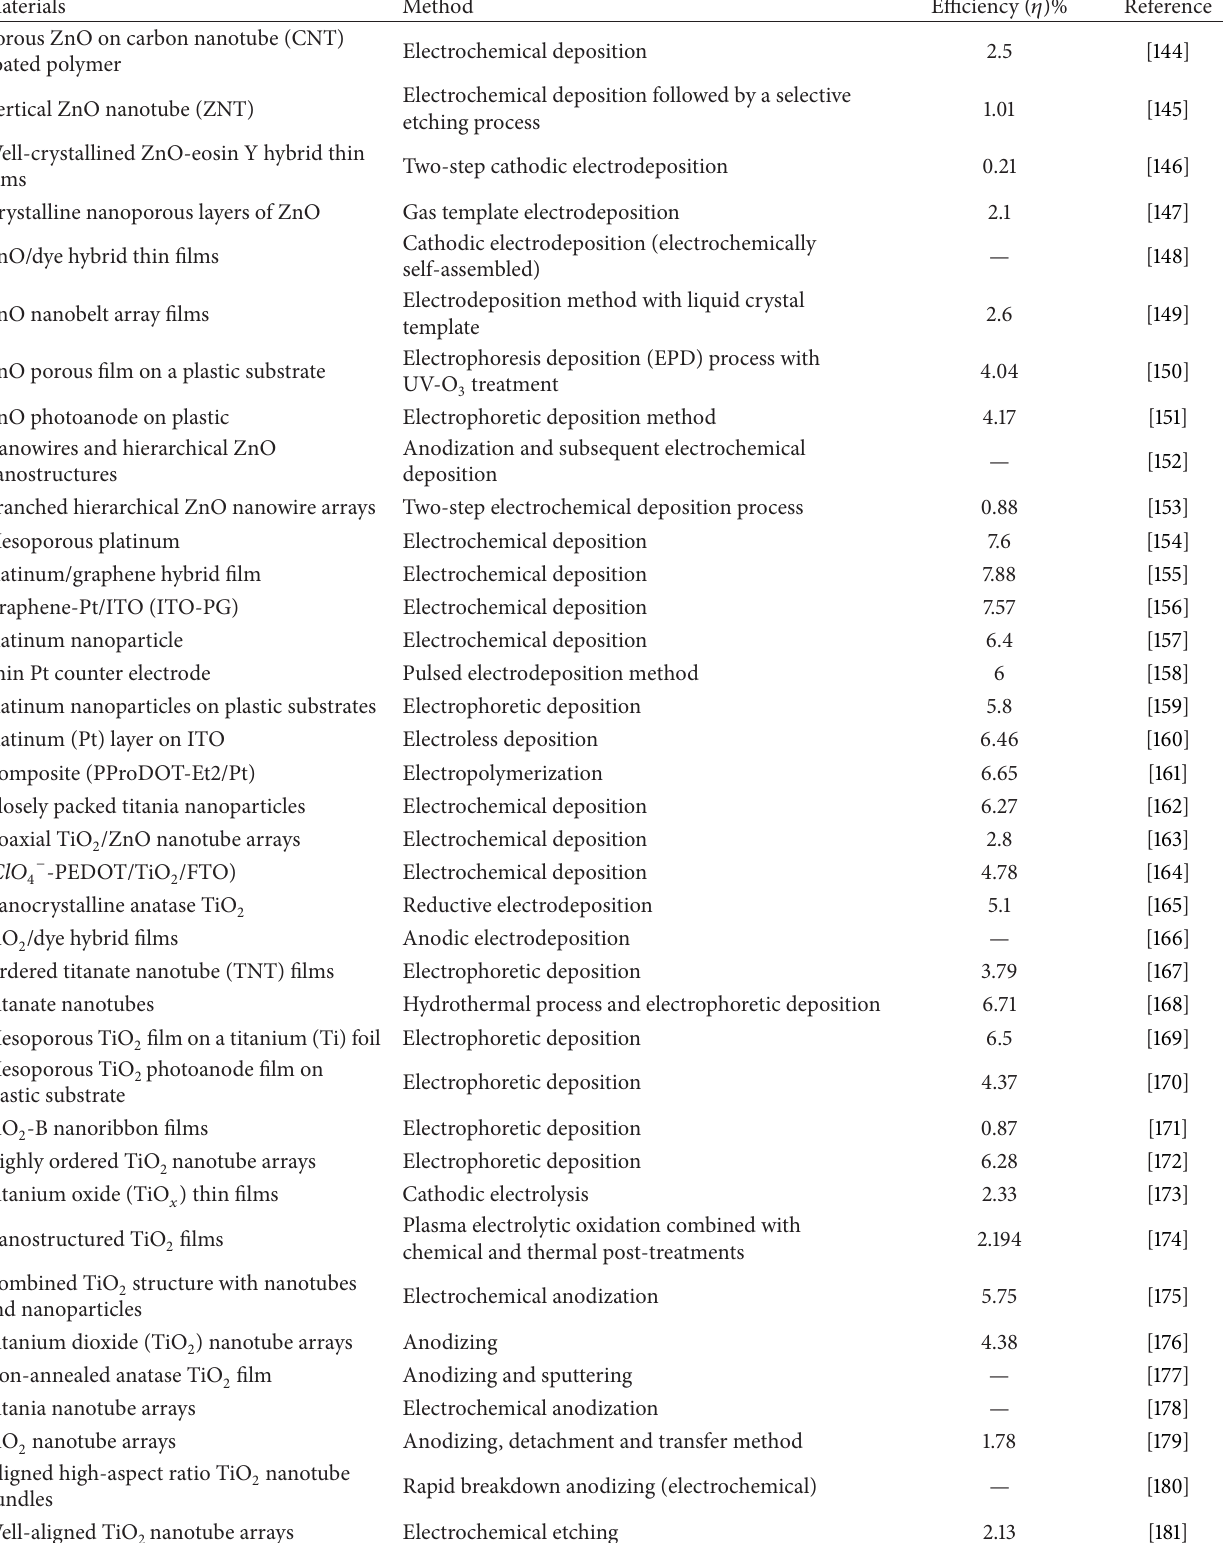
Table 3: Different electrochemical deposition methods used in